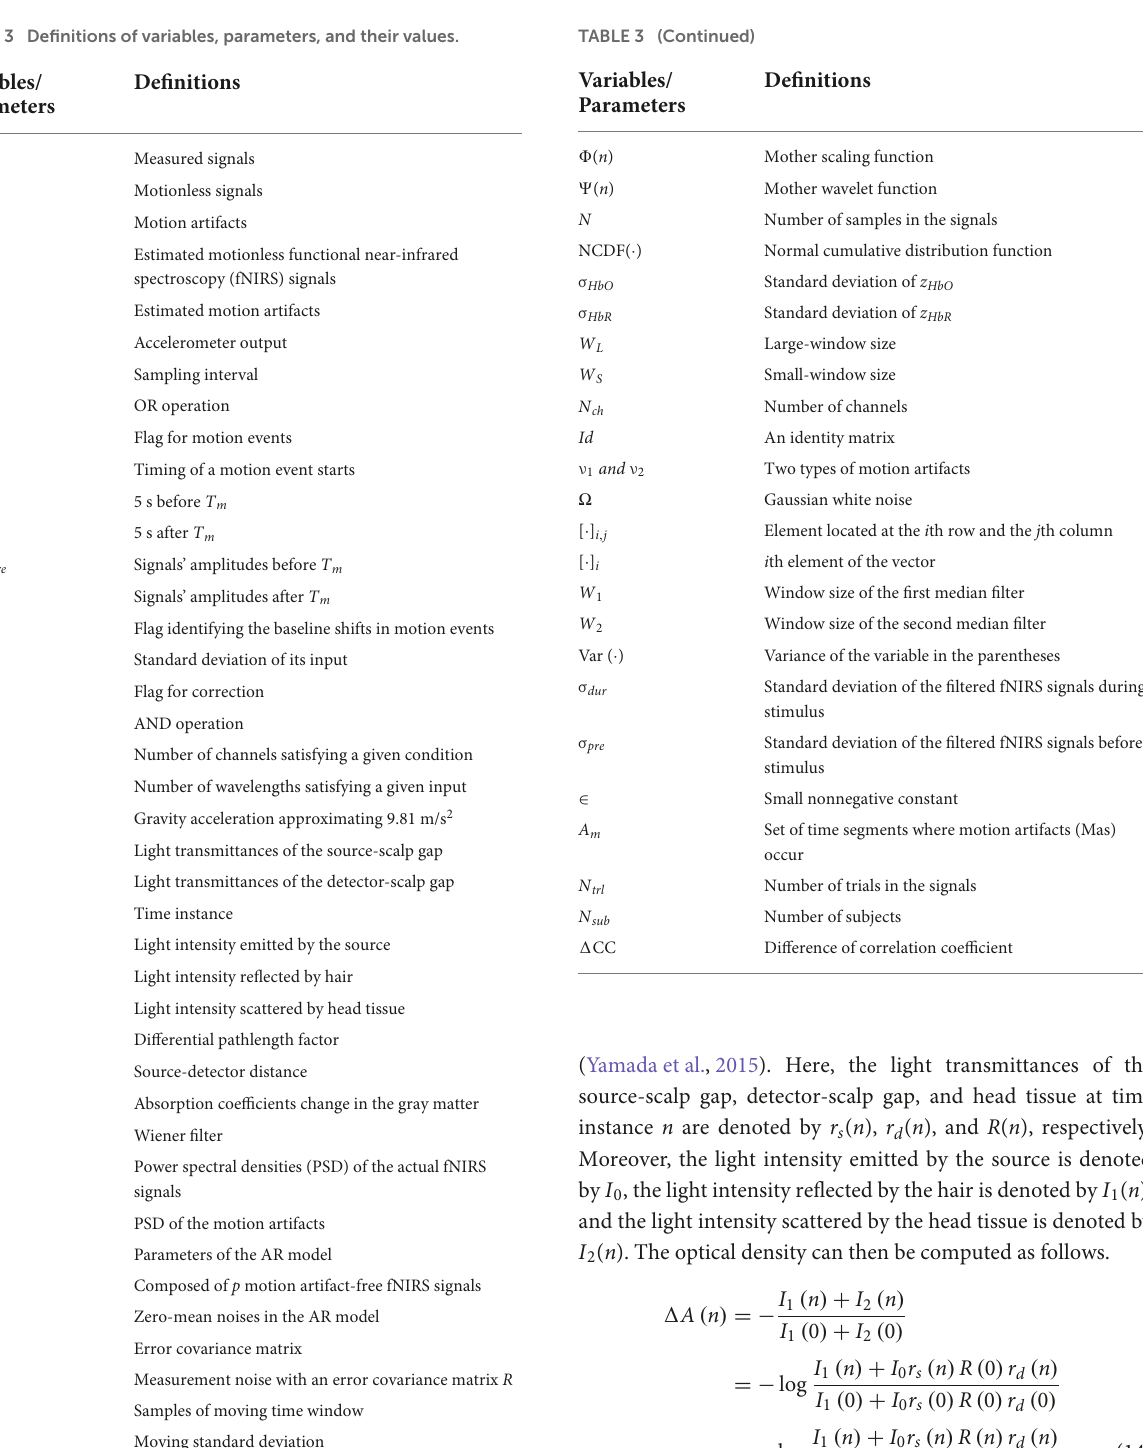
TABLE 3 Definitions of variables, parameters, and their